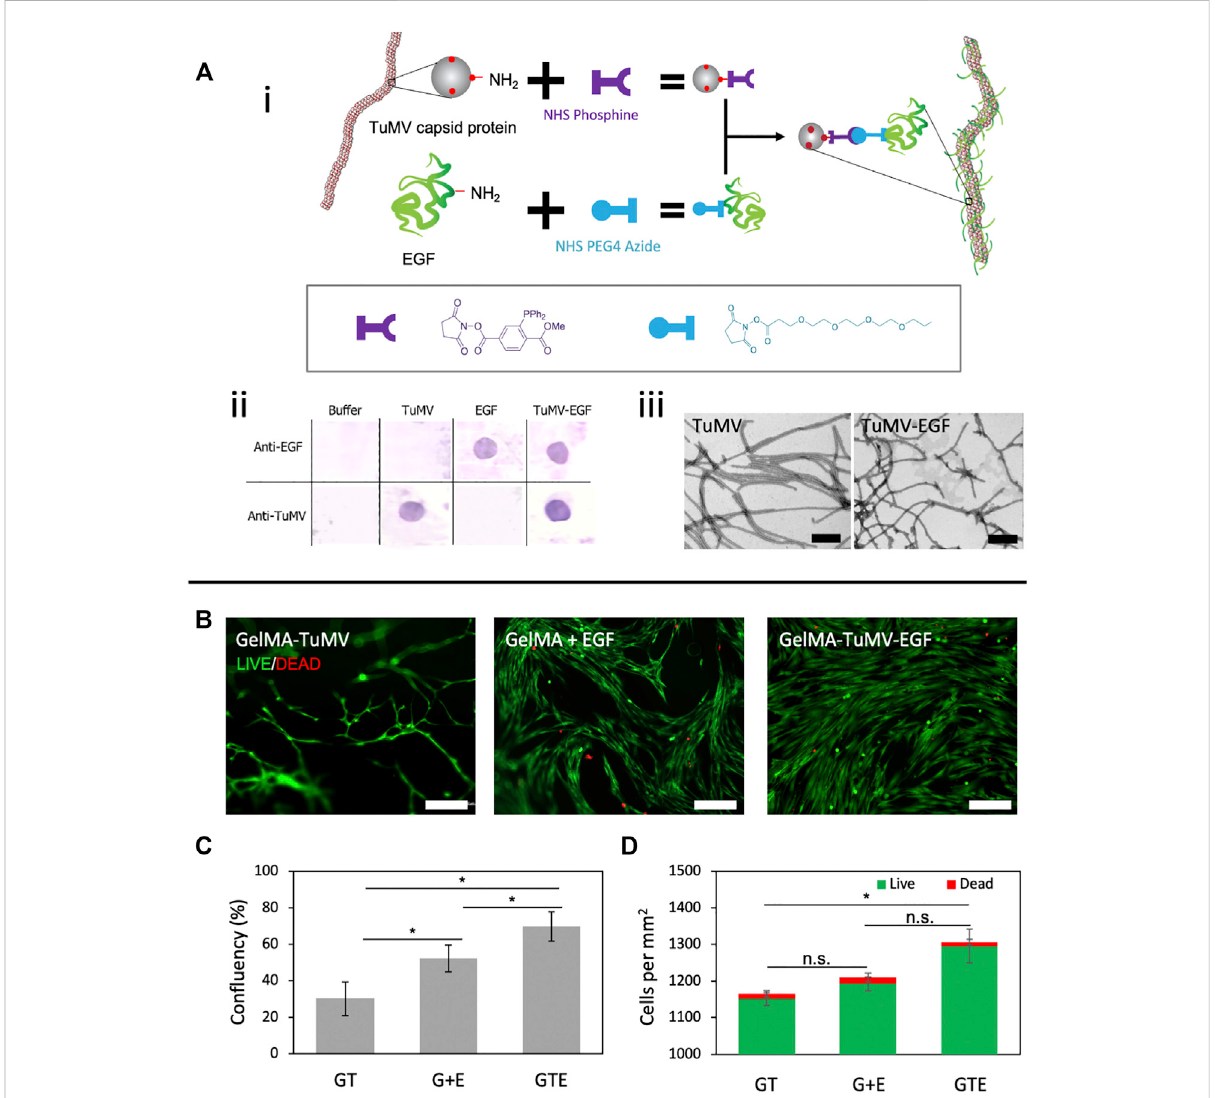
FIGURE 3 TuMV-EGFbioconjugationanditseffectoncellproliferation. (A) BioconjugationstrategytotetherEGFontoTuMV.(i)Schematicrepresentation oftheconjugationviaaStaudingerreactionbetweenphosphineandazide.(ii)Dot-BlotimmunoassayrevealingthesuccessfulconjugationofEGFon TuMV surface. (iii) Morphology of TuMV and TuMV-EGF nanomeshes visualized by TEM. Scale bars 200 nm. (B) LIVE/DEAD ® assay of BJ fi broblasts cultured on GelMA coated with TuMV [GelMA-TuMV (GT)], GelMA with added EGF in the cell culture media [GelMA + EGF (G + E)], and GelMA coatedwithbioconjugatedTuMV(GelMA-TuMV-EGF[GTE])for72 h.Scalebars=200 μ m. (C) Con fl uence,and (D) countsoflivecellsanddeadcells evaluated by image analysis from LIVE/DEAD ® micrographs ( n =